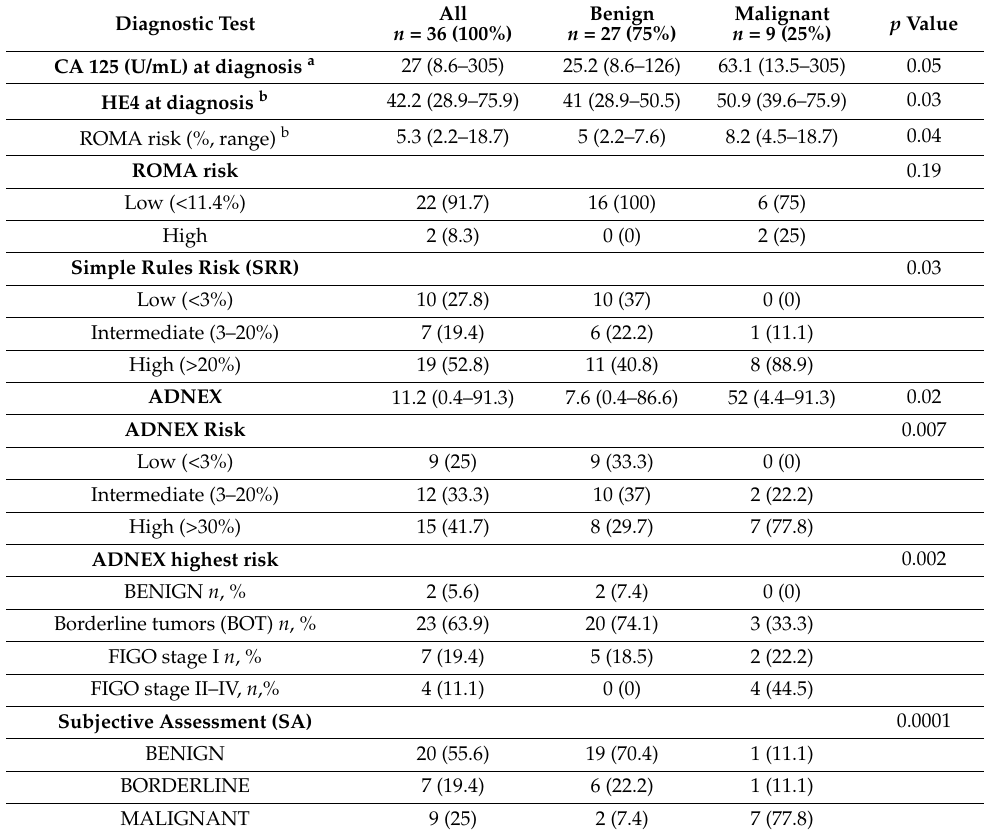
Table 4. Tumor markers concentrations and the prognostic tests results in benign and malig- nant